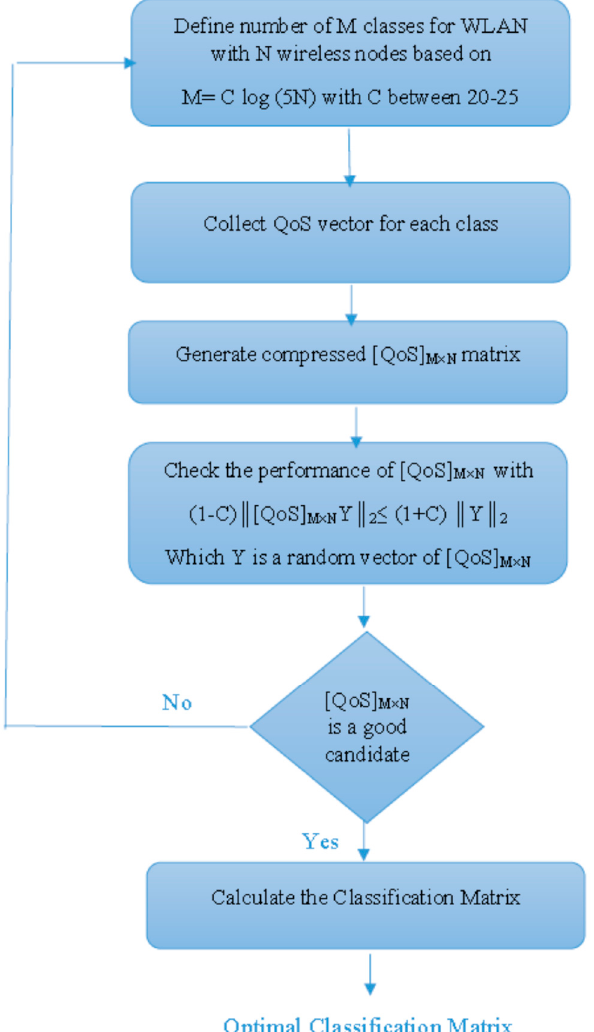
Figure 2. The proposed Real-Time Network Traffic Classification (RTNTC) algorithm.